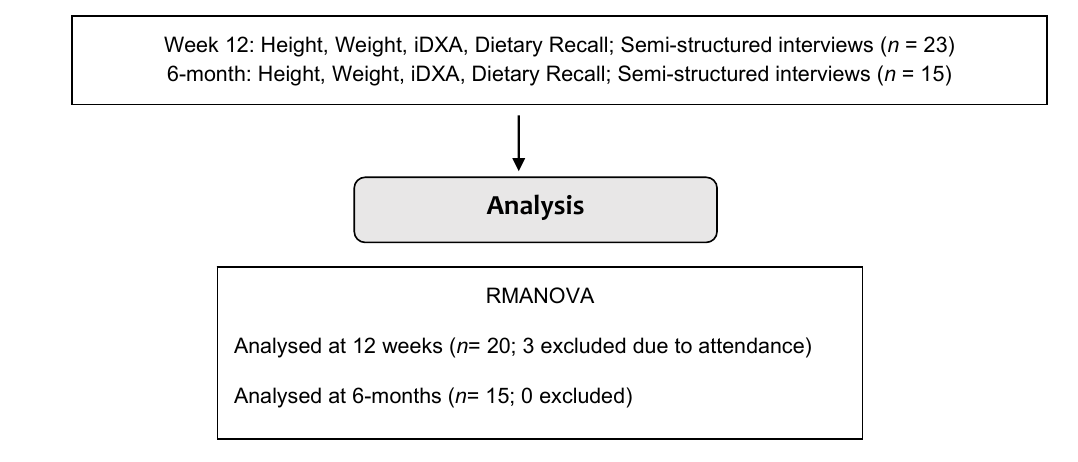
Figure 1. Study Flow Diagram.